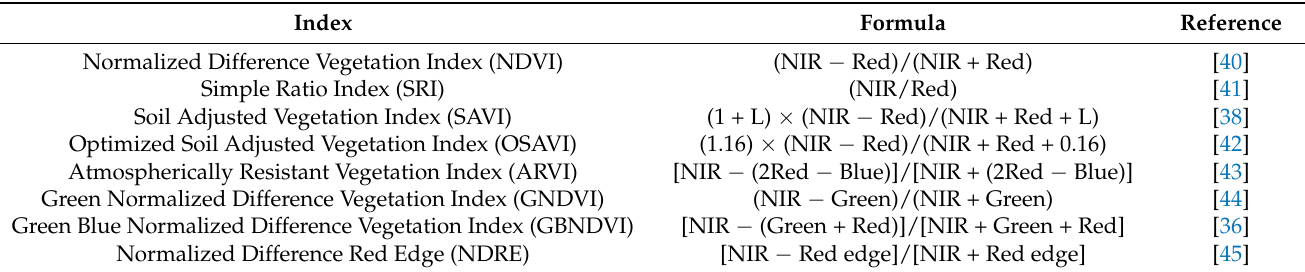
Table 2. The empirical vegetation indices used in this study and their mathematical formulas. Blue (445–517 nm), Green (507–586 nm), Red (626–696 nm), Red Edge (698–749 nm), NIR (765–899 nm) and L is the soil background adjustment factor with 0.5 commonly used for medium density vegetation